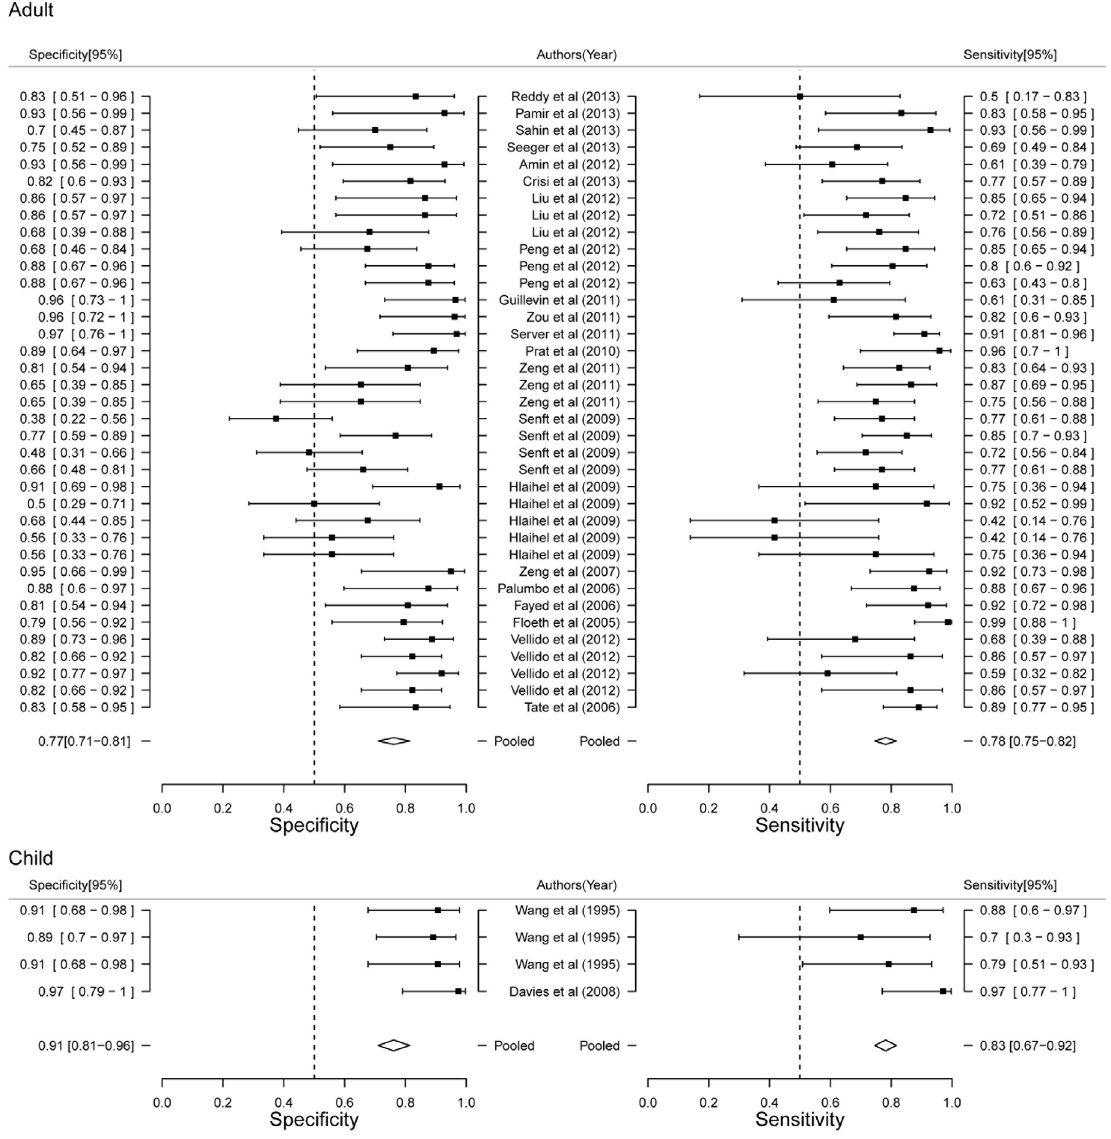
Figure 5. Forest plot of estimate of diagnostic accuracy of adult and child stratified meta-analysis.